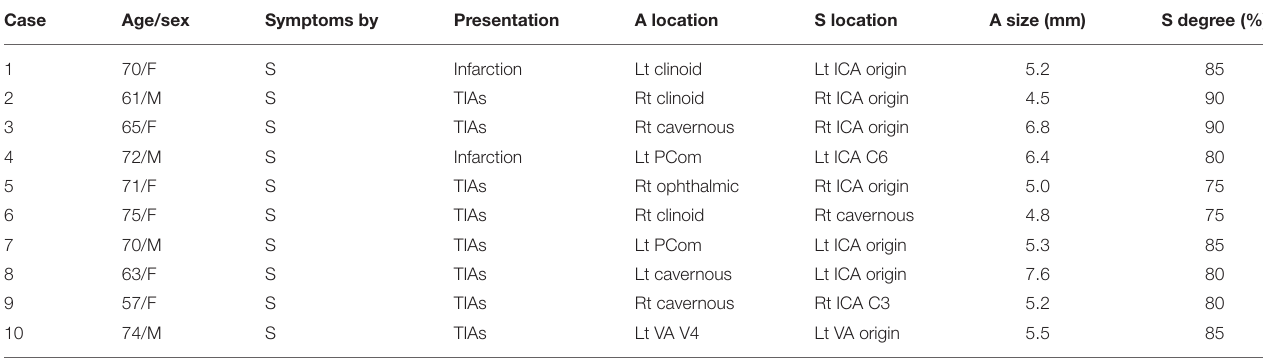
TABLE 1 | Characteristics of our case series.